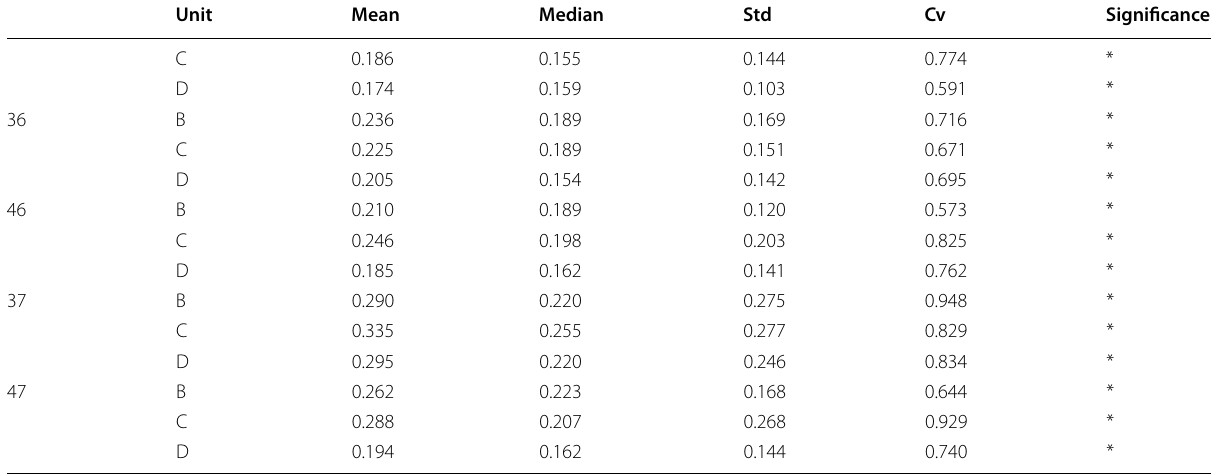
Table 6 Comparison between units B (Carestream CS 3600), C (CEREC Omnicam) and D (Trios 3Shape) for inter-arch